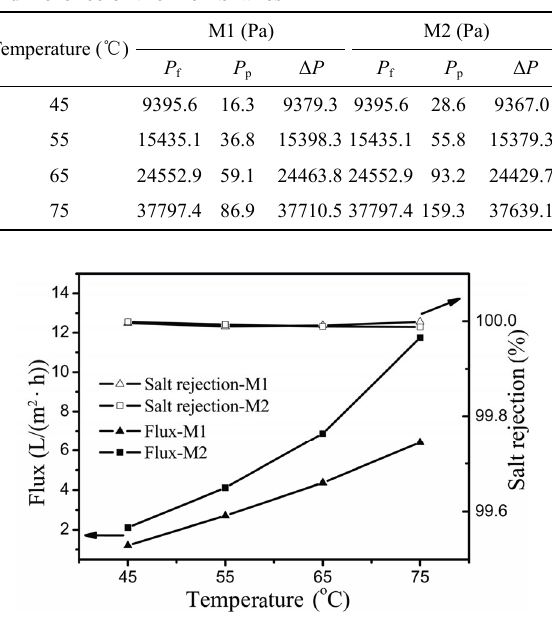
Fig. 7 Water flux of M1 and M2 as a function of the feed